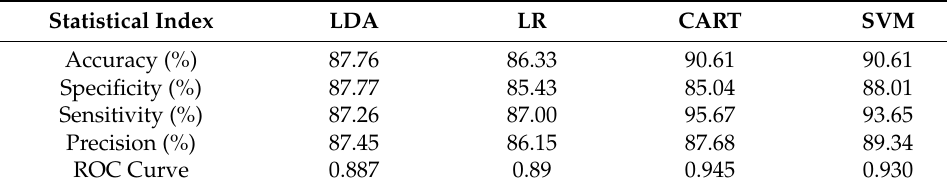
Table 4. Predictive capability of urban flood models using the testing